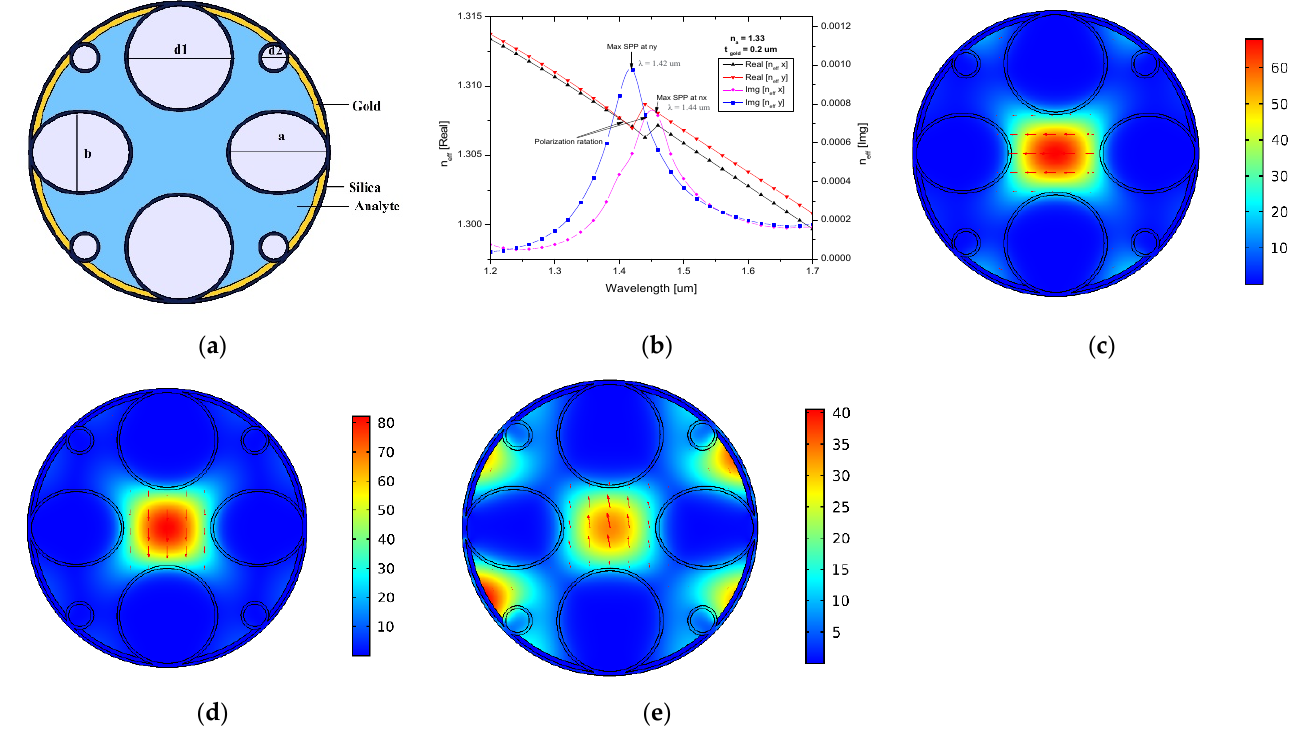
Figure 1. ( a ) Graphical representation of the proposed HC-NCF sensor. ( b ) Dispersion relations of the core-guided mode as a function of wavelength. Electric field distribution of ( c ) X-polarized mode, ( d ) Y-polarized mode, and ( e ) plasmon mode.